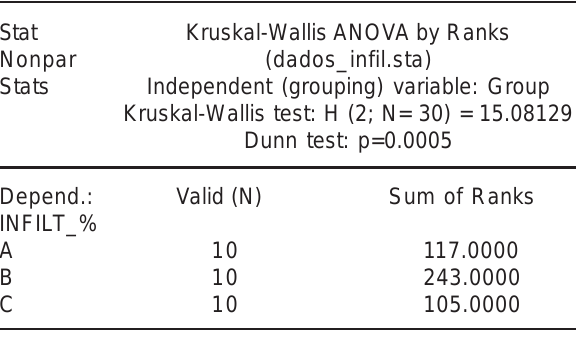
TABLE 2- Percent dye leakage for the tested materials and plug